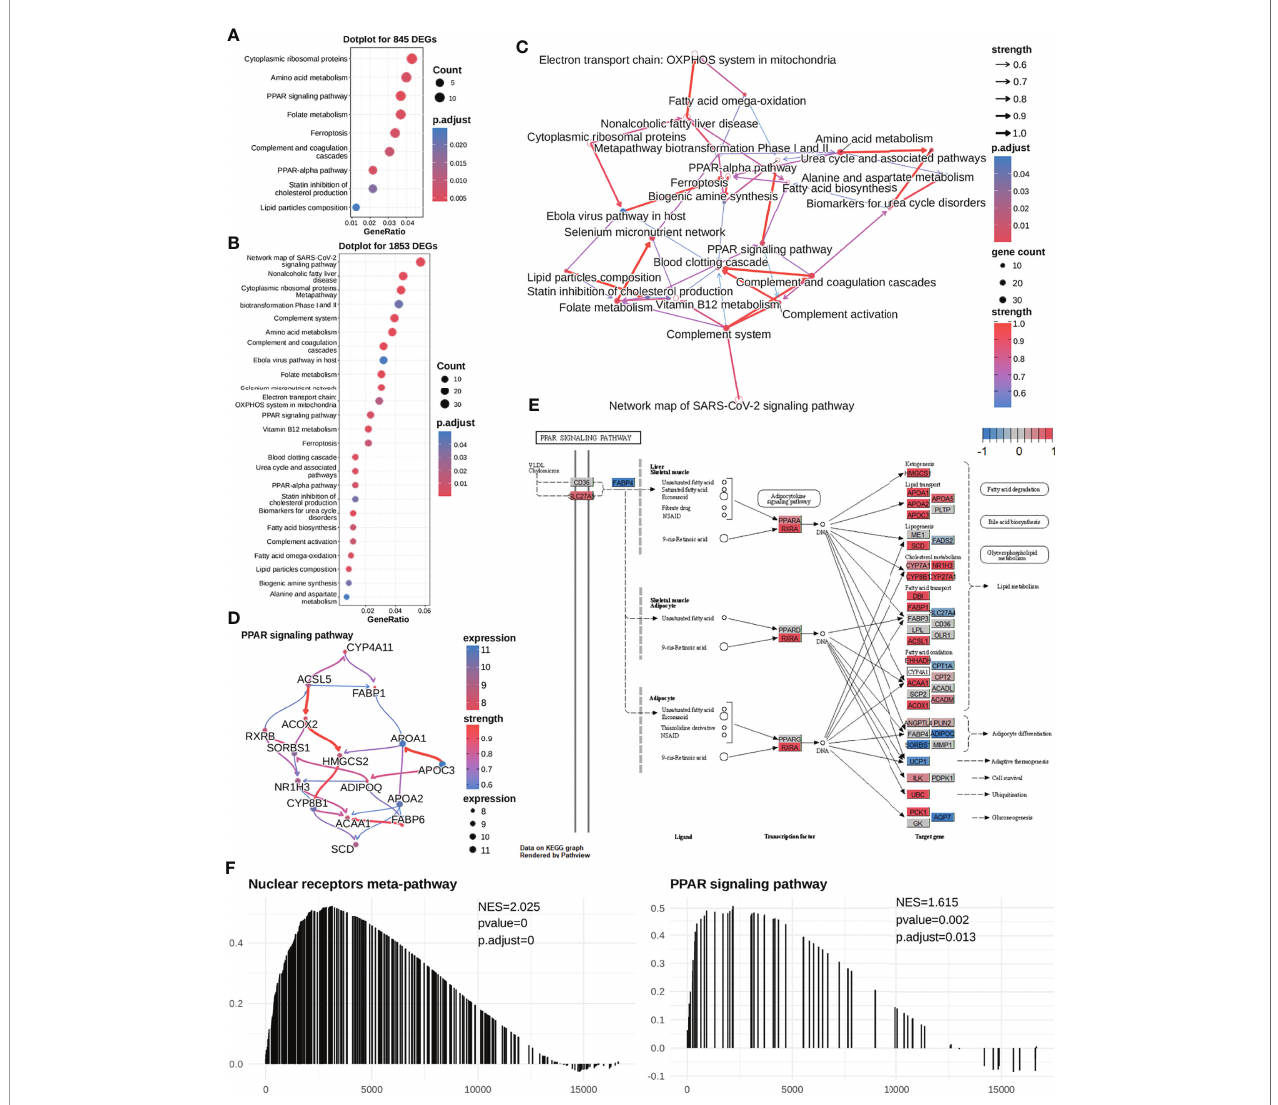
FIGURE 3 | The high mRNAsi subgroup (sorafenib resistant) exhibits higher expression levels of most genes in the PPAR signaling pathway in HCC cells. (A) We fi rst selected 845 DEGs for performing functional analysis and found that these DEGs were signi fi cantly enriched in the PPAR signaling pathway, cytoplasmic ribosomal proteins, folate metabolism, etc. (B) Next, we selected 1853 DEGS for performing enrichment analysis and found that the DEGs were signi fi cantly enriched in lipid metabolism-related pathways. (C) Enriched pathway regulatory network for 26 pathways. (D) The gene regulatory network for the PPAR signaling pathway. (E) Visualization of expression of the PPAR signaling pathway (most genes were highly expressed in the mRNAsi-high subgroup). The expression of the gene in both mRNAsi subgroups ranges from -1 to 1. A value closer to 1 means that the gene is highly expressed in the high-mRNAsi subgroup (red color); conversely, it is highly expressed in the low-mRNAsi subgroup (blue color). Most of the genes in the PPAR signaling pathway are highly expressed in the high-mRNAsi subgroup. (F) Meanwhile, GSEA was performed to compare the high-mRNAsi and low-mRNAsi subgroups, to identify upstream pathways of PPAR signaling that were up-regulated in the mRNAsi-high subgroup, NES =2.049. PPAR signaling pathways were up-regulated in the mRNAsi-high subgroup, NES =